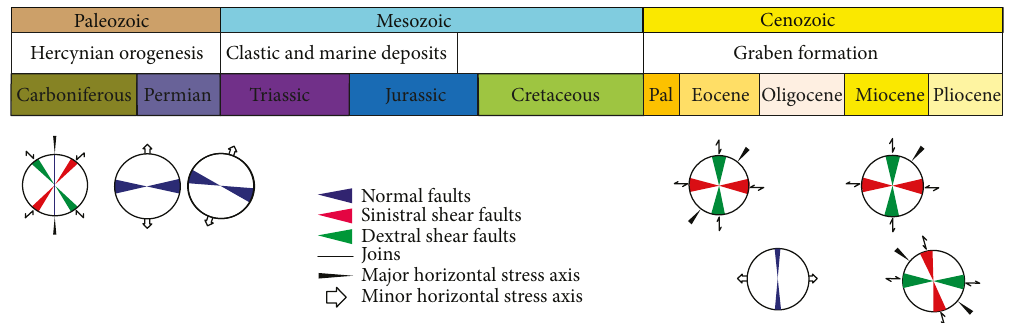
Figure 3: Synthesis of main brittle tectonic phases and associated fracture set directions since the Hercynian orogenesis in the Rhine graben and around the area modi fi ed after [117, 118] based on [37, 45, 48]. The circles represent the main orientation of fractures related to main stress axis (north on the top, east on the